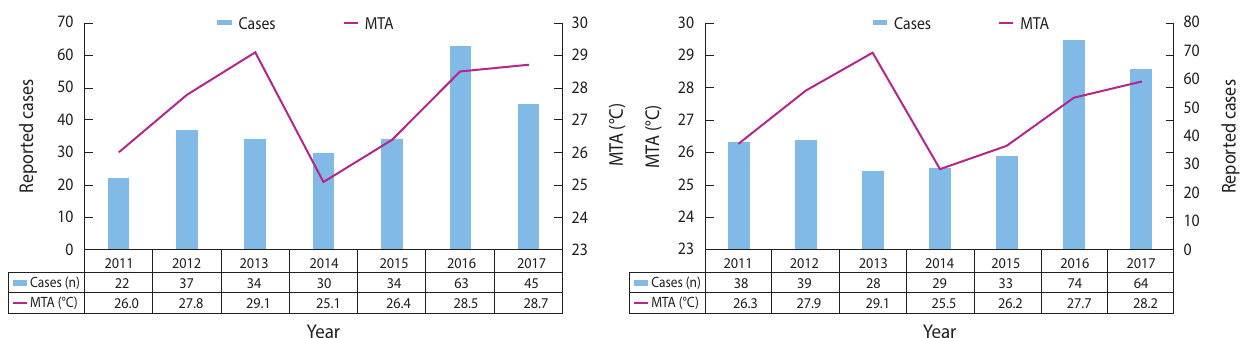
Figure 2. The reported cases of scrub typhus and mean temperature of August (MTA) in Seogwipo-si (Spearman’s rho=0.14, p=0.76; Ken dall’s tau-a=0.24,